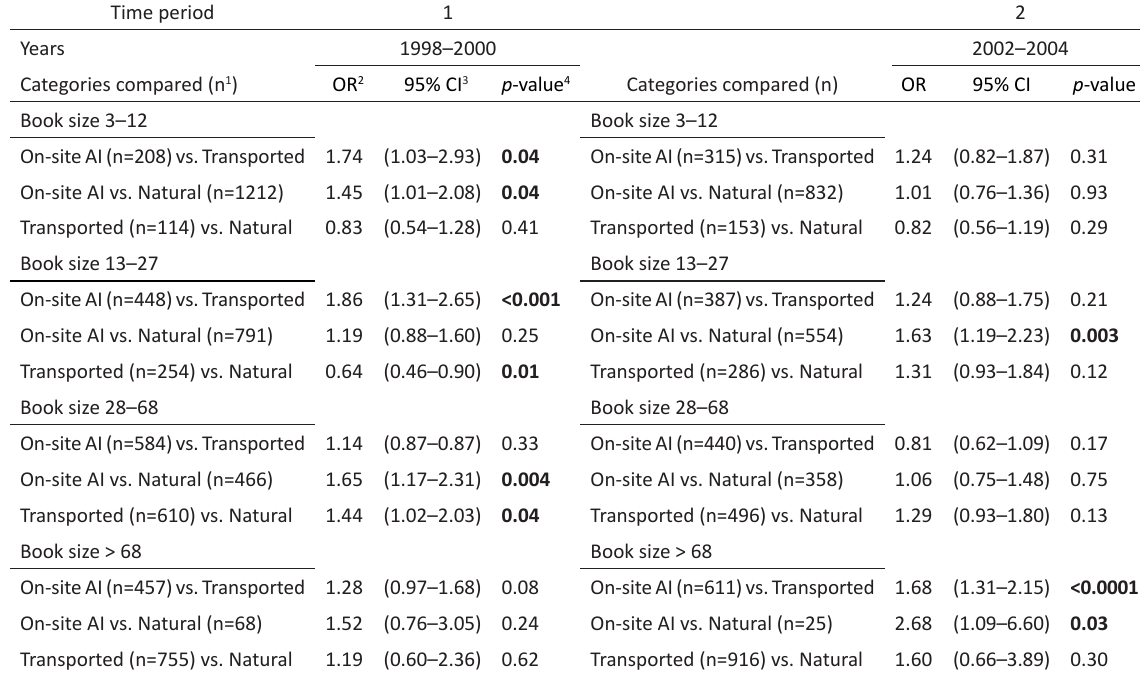
Table 4. Multivariable logistic mixed model results for mating types in different book size groups (mares/stallion/year) to test differences in foaling rates (FR) of Finnhorse mares during two time periods. Models were performed separately for different book size groups in both periods and adjusted for mare age and mare status group. Mare and stallion were incorporated as random effects. An odds ratio (OR) >1 indicates that the FR in the first-mentioned group was higher than in the comparison group, and 0<OR<1 indicates the